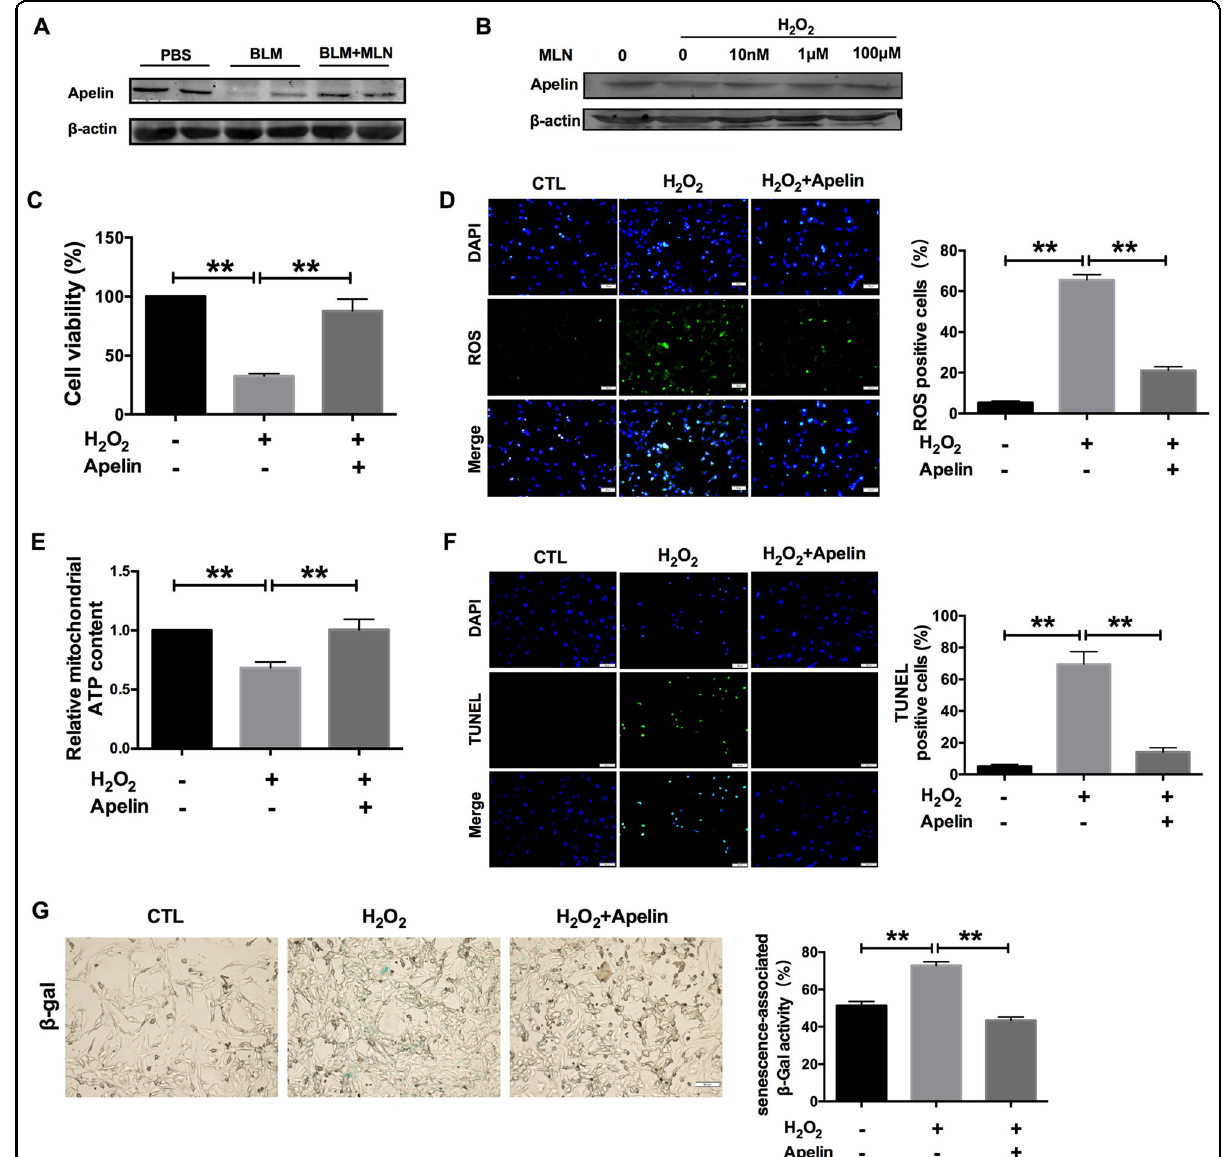
Fig. 5 Apelin 13 participated in the process of by which melatonin prevents lung injury. a Western blot assays were performed to determine the protein levels of apelin 13 in lung tissues from mice in the PBS, BLM, and BLM + MLN groups. b The protein expression of apelin 13 in TC-1 cells after treatment with different concentrations of melatonin. c The MTT assay showed the effect of apelin 13 on the viability of H 2 O 2 -impaired TC-1 cells. n = 7; ** P < 0.01. d Comparison of ROS production in TC-1 cells exposed to apelin 13. Green, ROS; blue, DAPI. Scale bars, 50 μ m. ** P < 0.01. e Apelin 13 impacted the mitochondrial ATP content in cells treated with H 2 O 2 . n = 5; ** P < 0.01. f Representative images of the TUNEL assay in TC-1 cells are shown. Apelin 13 decreased the H 2 O 2 -induced increase in apoptosis. Green, TUNEL-positive TC-1 cells; blue, DAPI. Scale bars, 50 μ m. ** P < 0.01. g Apelin 13 signi fi cantly decreased cell senescence, as evidenced by staining for senescence-associated β -gal activity. Right, relative percentage of senescence-associated β -gal activity. ** P <